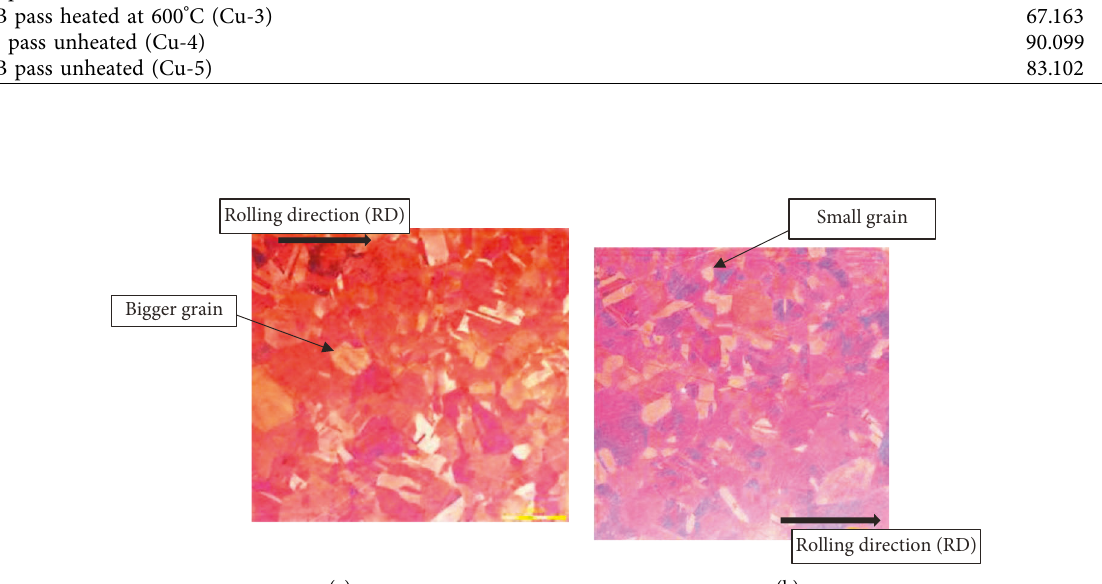
Figure 3: Optical microscope micrographs of heated samples at 277X: (a) 1 st ARB pass (Cu-2) and (b) 2 nd ARB pass